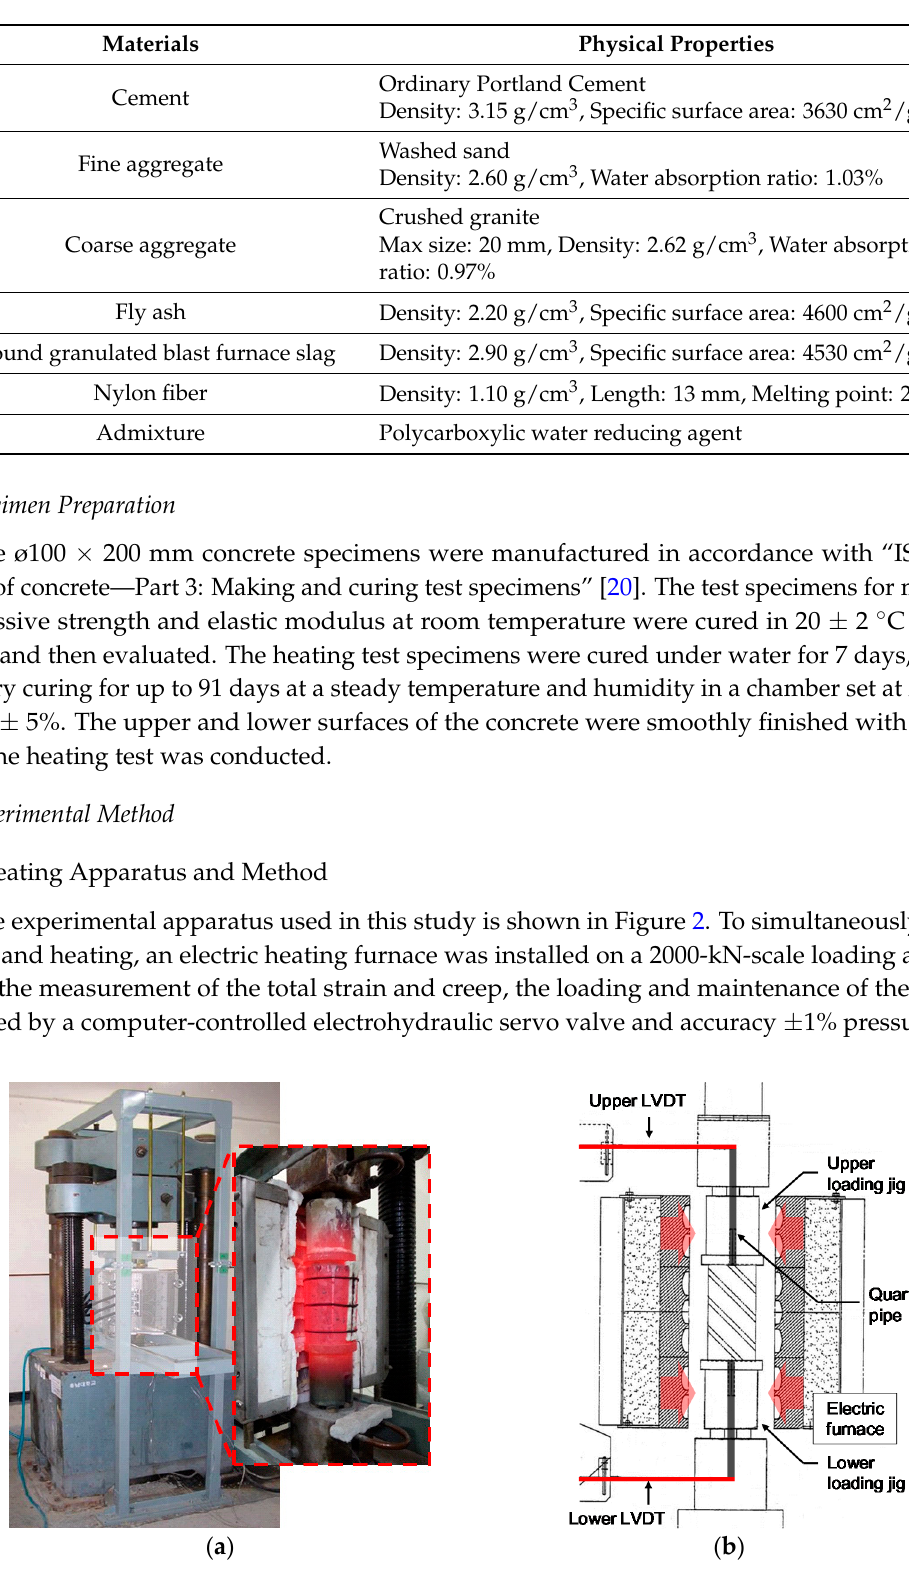
Figure 2. Experimental apparatus: ( a ) heating and loading apparatus; ( b ) geometry of apparatus.